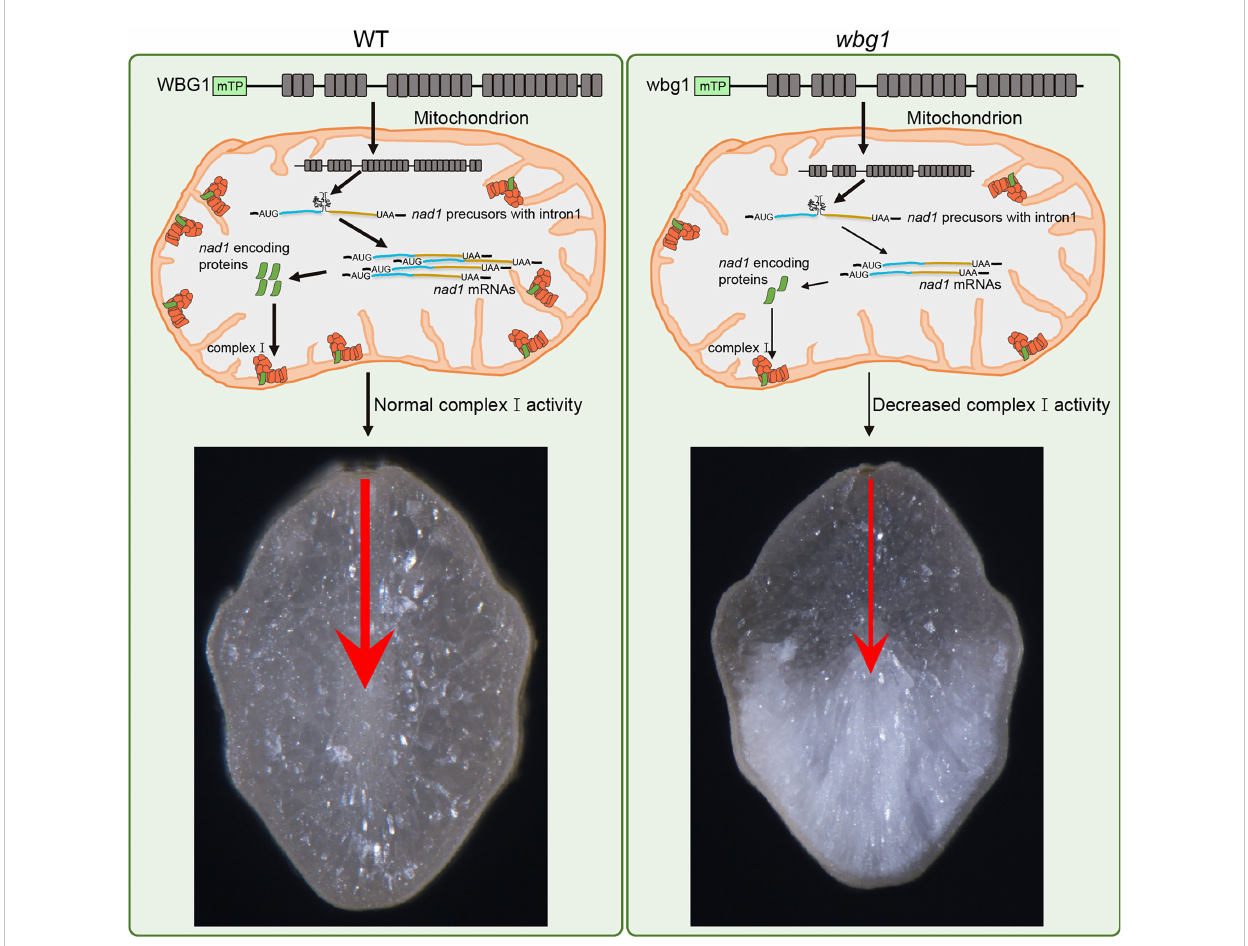
FIGURE 8 A proposed working model of WBG1 in regulating rice grain chalkiness. In wild-type (WT) (left), nad1 precursors with intron1 in mitochondria can be normally spliced by WBG1 and produce a certain level of nad1 mRNA. The nad1 mRNA encoded protein forms the required amount of mitochondrial complex I, thus maintaining normal mitochondrial function and keeping the transport ef fi ciency of fi lling assimilates from grain dorsal to belly. mTP, predicted mitochondrion-targeted peptide. Each gray box represents a PPR motif. The blue bold line represents nad1 exon 1, the brown bold line represents nad1 exons 2 – 5, and the curved line between them represents nad1 intron1. In wbg1 mutant (right), the loss of two PPR motifs at the C- terminal of wbg1 leads to a reduction in splicing ef fi ciency of nad1 intron1, resulting in a decrease in nad1 mRNA level. Then, the activity of complex I, which is composed of nad1 encoded protein, was decreased. Therefore, the transport ef fi ciency of fi lling assimilates from the dorsal to belly is reduced, resulting in white belly